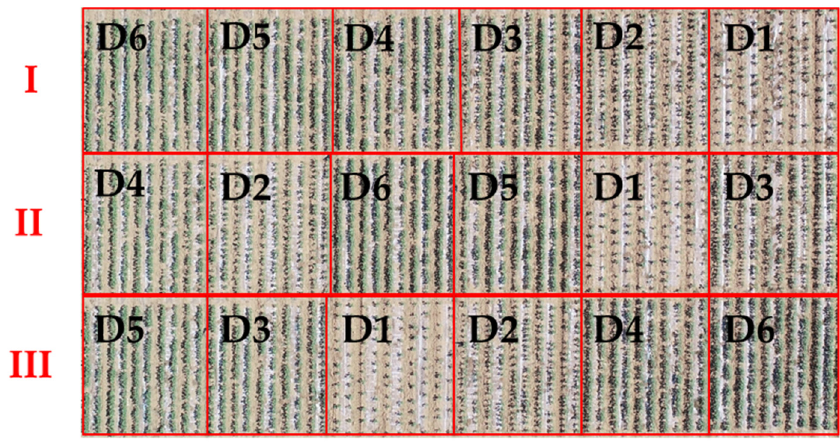
Figure 1. The graphic illustration of sowing planting patterns in 2019 and 2020.